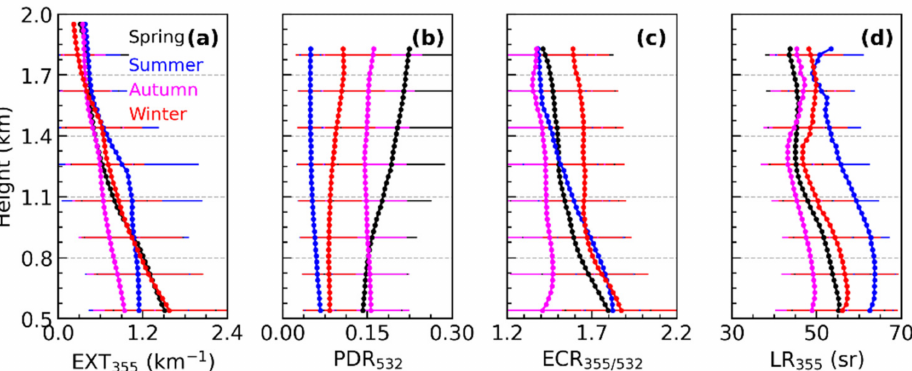
Figure 11. Average vertical profiles of aerosol optical parameters in different seasons in BTH region. Vertical structure of ( a ) EXT 355 , ( b ) PDR 532 , ( c ) ECR 355/532 , and ( d ) LR 355 . The envelope over the horizontal bars represent one standard deviation at each